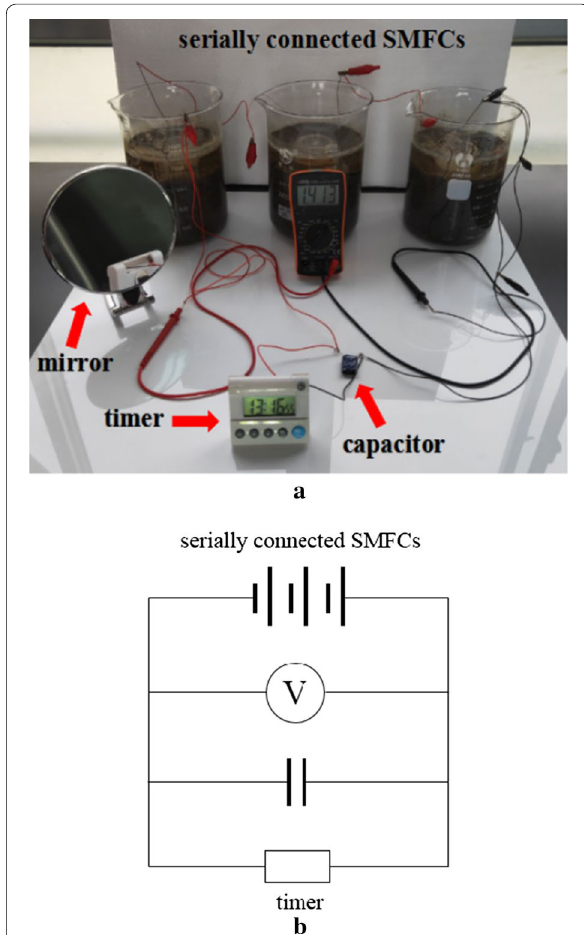
Fig. 1 a A photo of the serially connected sediment microbial fuel cells (SMFCs) and b circuit diagram. The voltmeter shows a voltage of 1.413 V over the timer, which has been running for 13 h 16 min 55 s. The mirror shows the battery box of the timer, indicating that the battery was replaced by the